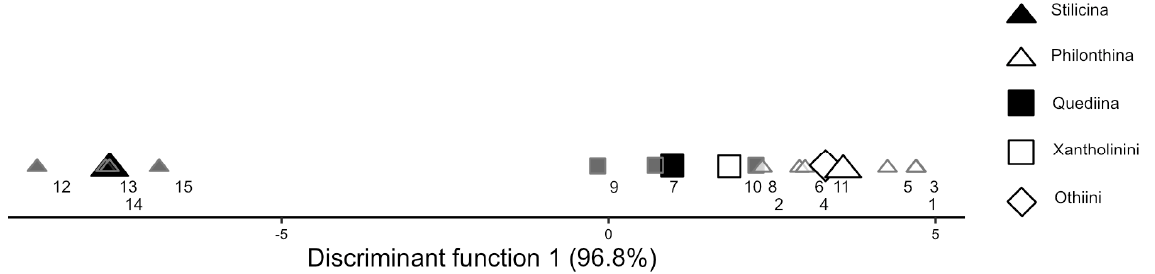
Figure 15. Plot of linear discriminant analytical separation of the tribes. Small transparent shapes represent individual species, large dark shapes represent group centroids. Only one species was analysed for Othiini and Xantholinini. The data (Appendix A, Table A1) were log10-transformed prior to the analysis. Only the first discriminant function, separating Stilicina from the Quediina and Philonthina, is plotted. It shows the following standardized canonical discriminant coefficients: head length/pronotum length: − 0.60; PC1: 0.76.